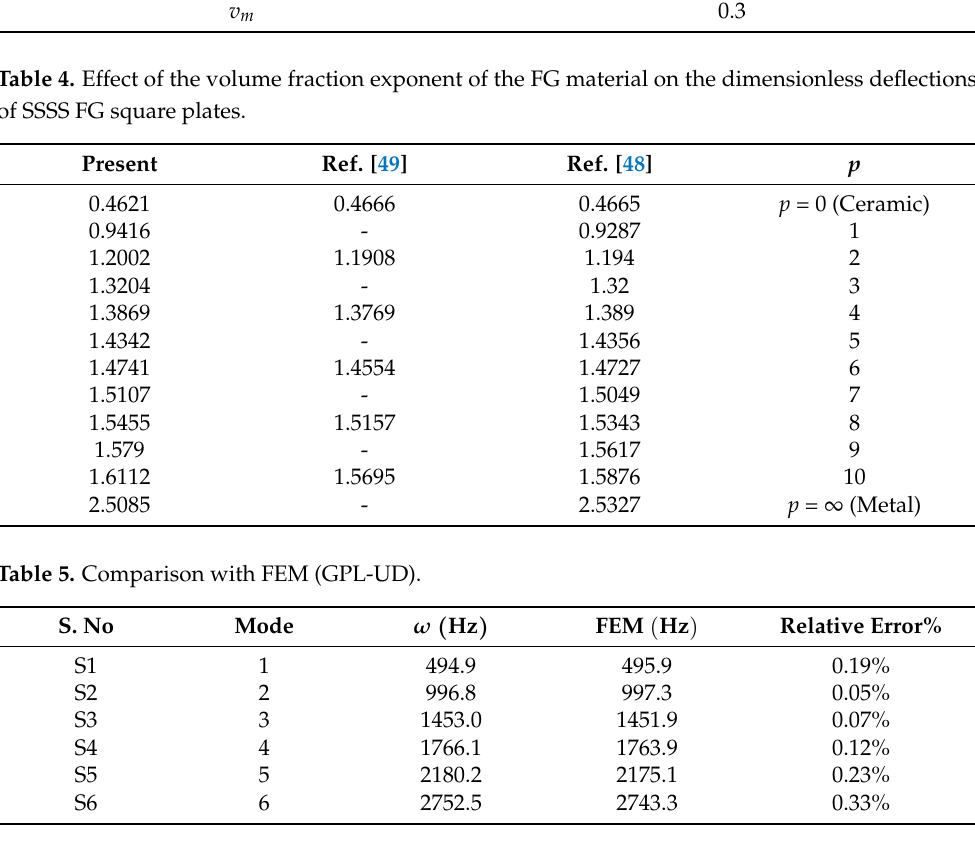
Table 6. Comparison between FEM-based predictions and results from our formulation